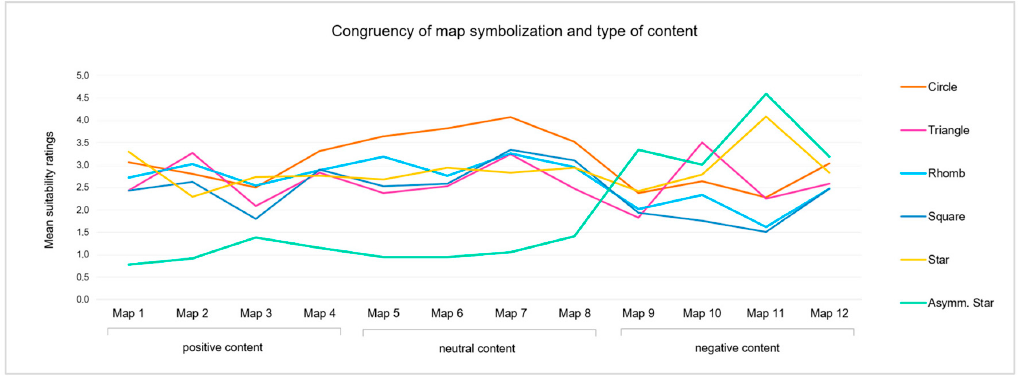
Figure 3. Mean ratings of map content and symbolization (in)congruence.